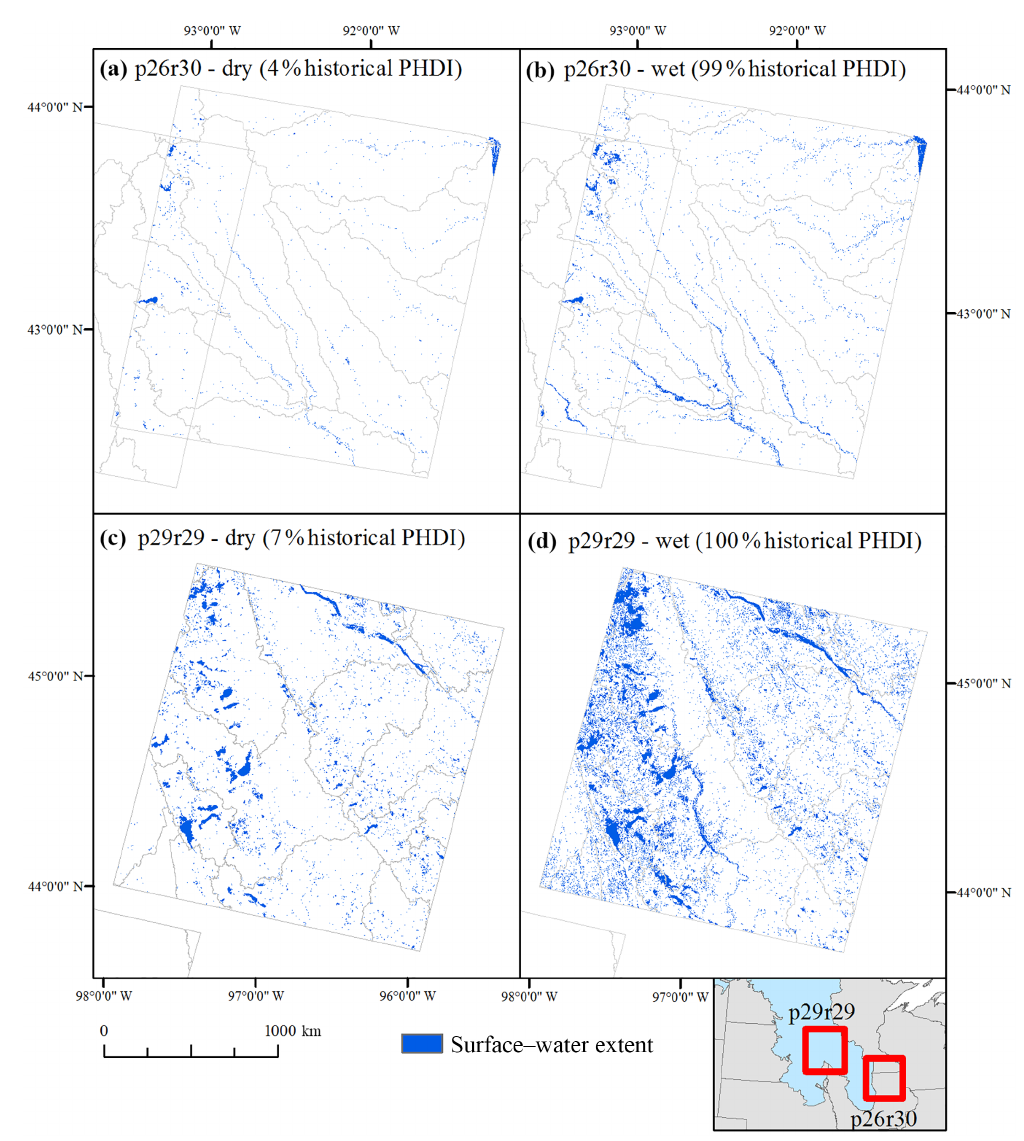
Figure 4. Mean surface water abundance and the amount of “wetting up” varied substantially between different Landsat path/rows. Portions of the Northern Prairie (e.g., p26r30) showed relatively less surface water extent and expansion (a, b) while portions of the Prairie Pothole Region (e.g., p29r29) showed relatively more surface water extent and expansion (c, d) . Note: not all water is visible at this reduced scale. PHDI – Palmer Hydrological Drought